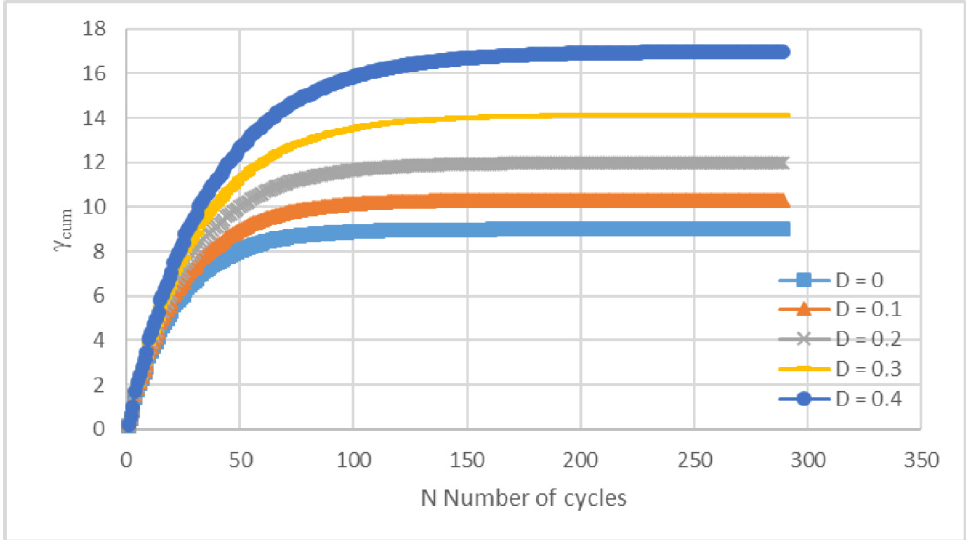
Figure 5. Evolution of accumulated plastic strain γ p with the number of cycles for different intensities of damage.